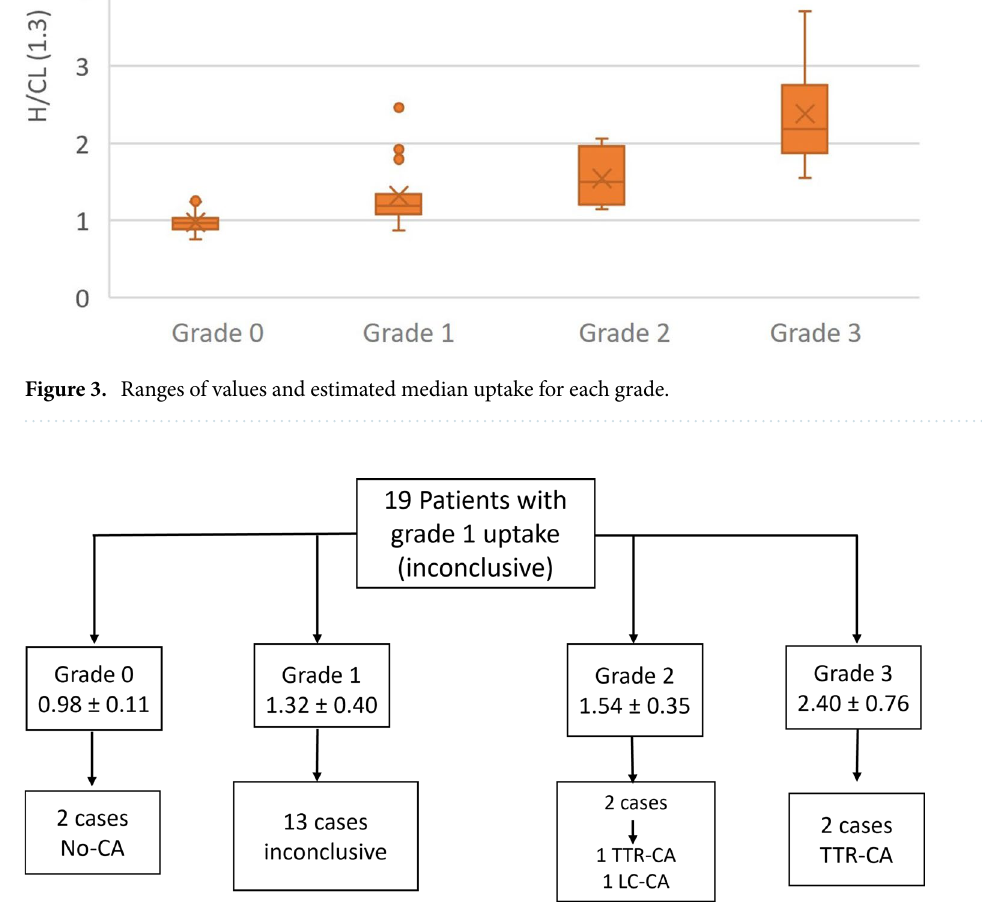
Figure 4. Reclassification of patients with grade 1 uptake with the proposed quantitative method.